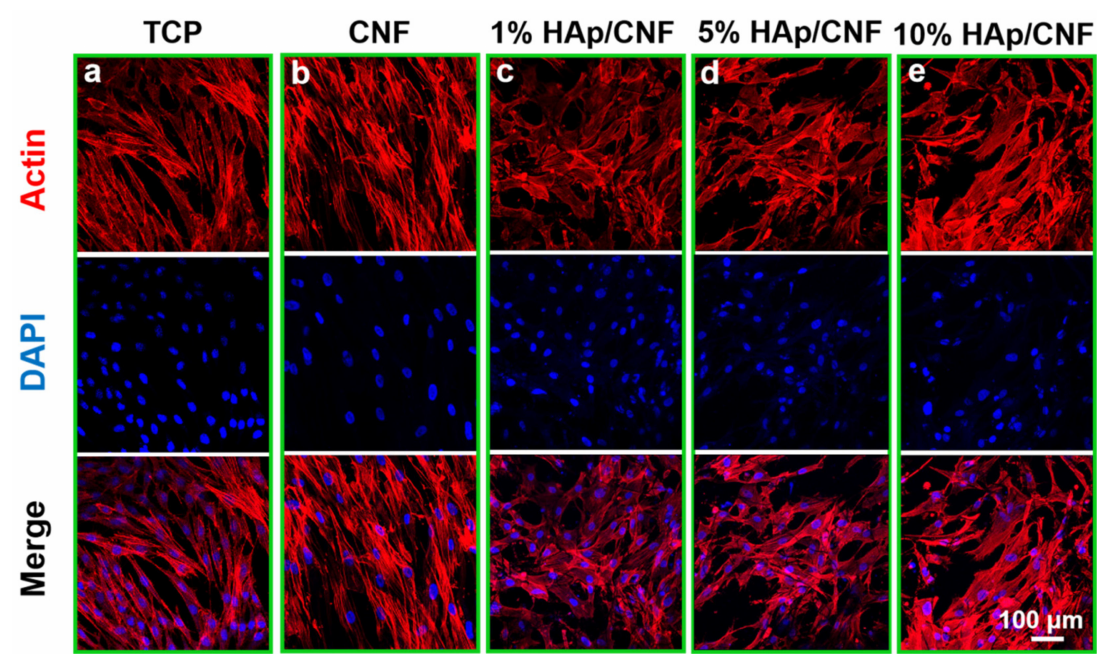
Figure 3. Adhesion and spreading of h-ADSCs on the surface of different materials after 7 days: ( a ) TCP. ( b ) CNF. ( c ) 1% HAp/CNF. ( d ) 5% HAp/CNF. ( e ) 10% HAp/CNF. Red indicates F-actin, as stained with rhodamine phalloidin, and nuclei were stained blue with DAPI. TCP: tissue culture plastic, CNF: carbonized fibers, HAp: